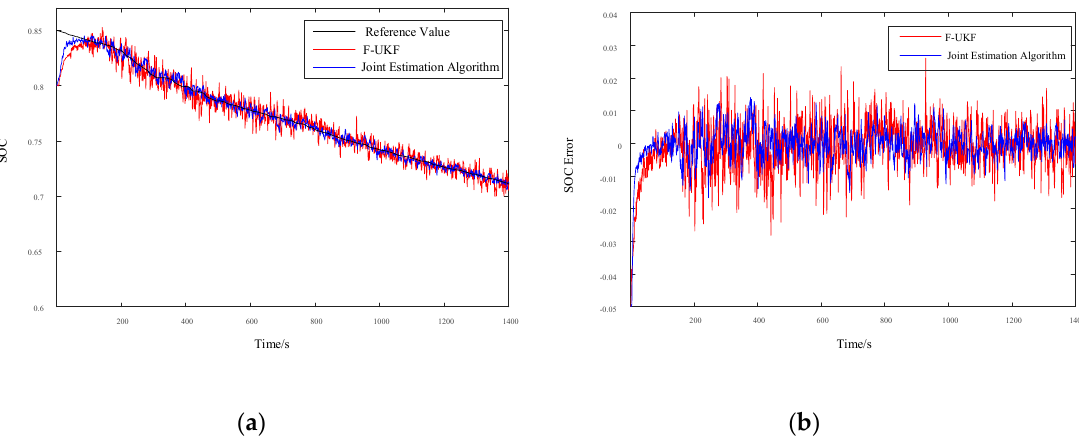
Figure 12. ( a ) SOC estimation curve of UDDS driving cycles based on the F-UKF and joint estimation algorithms. ( b ) SOC estimation error curve of UDDS driving cycles based on the F-UKF and joint estimation algorithms.